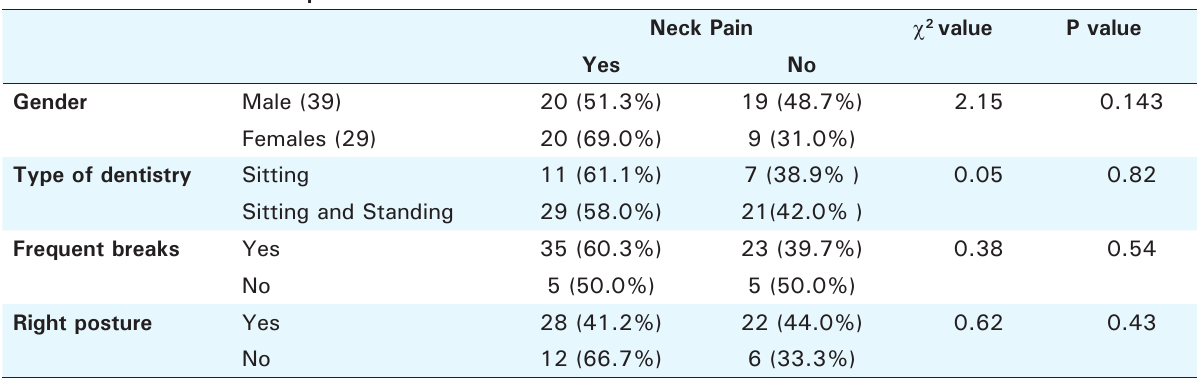
table 1. distribution of neck pain in relation to different variables